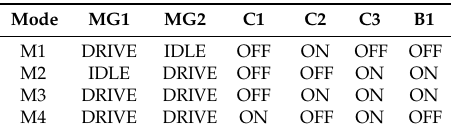
Table 1. Operational status of components in the different driving modes.